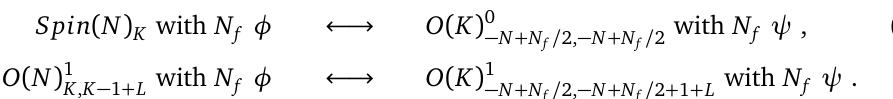
Figure 1: The phase diagram of Spin ( N ) gauge theory coupled to fermions in the vector representation. For large | m ψ | the infrared is a topological field theory, which is visible semiclassically. For small | m ψ | the theory spontaneously breaks the flavor symmetry and is described by a sigma model with Grassmannian target. There is a Wess-Zumino term, and stable strings, signaling confinement. The transition from the semiclassical phase to the quantum phase is weakly coupled in the dual bosonic variables ( φ or (cid:210) φ ). This diagram completes the discussion in [ 5 ] by specifying the discrete θ -parameters needed in the various gauge theories, and provides a non- trivial consistency check on that